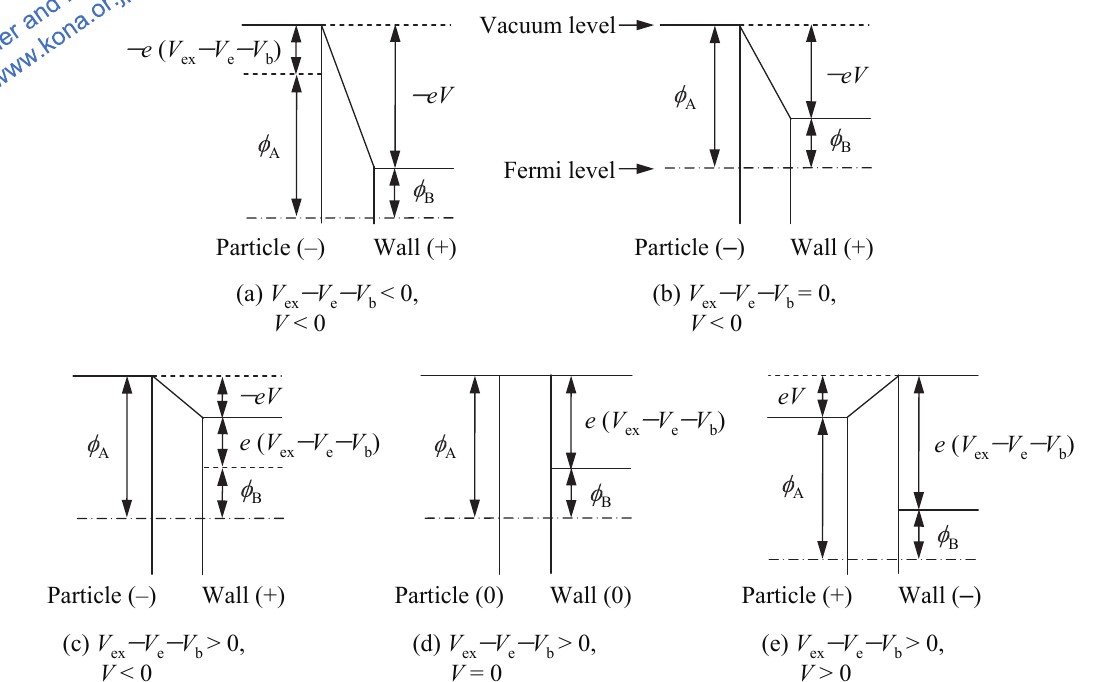
, V < 0, − V − V + V c e b ex c